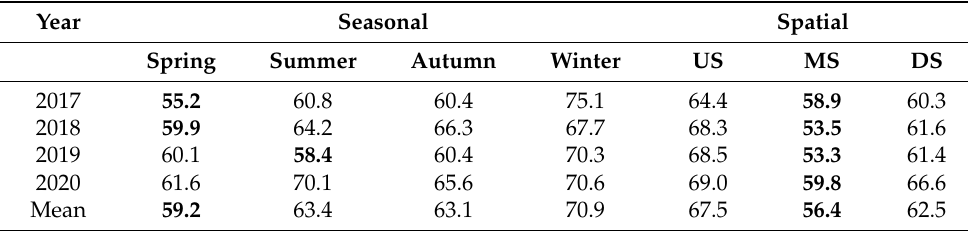
Note(s): WQI scores at the “Fair” grade (<60) are shown in bold. Spring, March to June; summer, July to September; autumn, October to December; winter, January to February; US, upstream (S1 to S2 site); MS, midstream (S3 to S5 site); DS, downstream (S6 site).